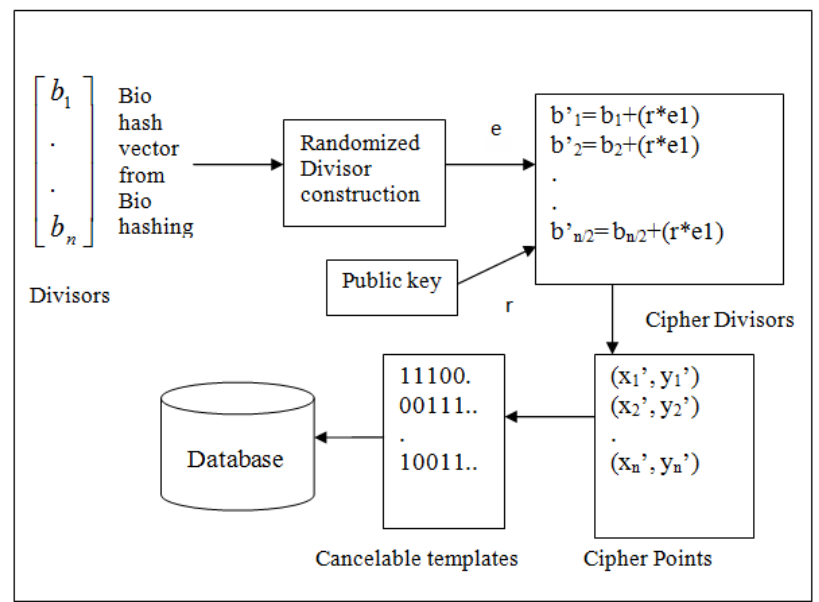
Figure 3. Signcryption for the generation of secure cancelable templates. Algorithm 2 : Bio Hash Code Converted into